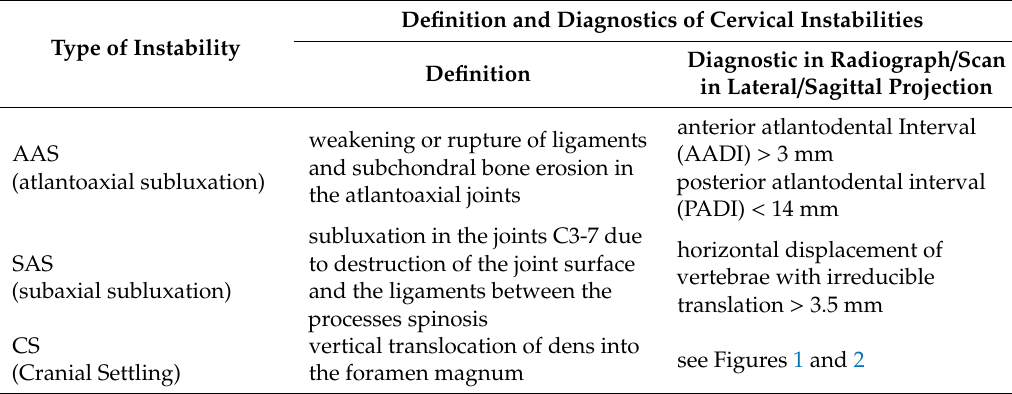
Figure 2. Various diagnostic criteria of cranial settling. Chamberlaine: Line from the dorsal end of the hard palate to the posterior border of the foramen magnum. If the dens is 3 mm above the line, a